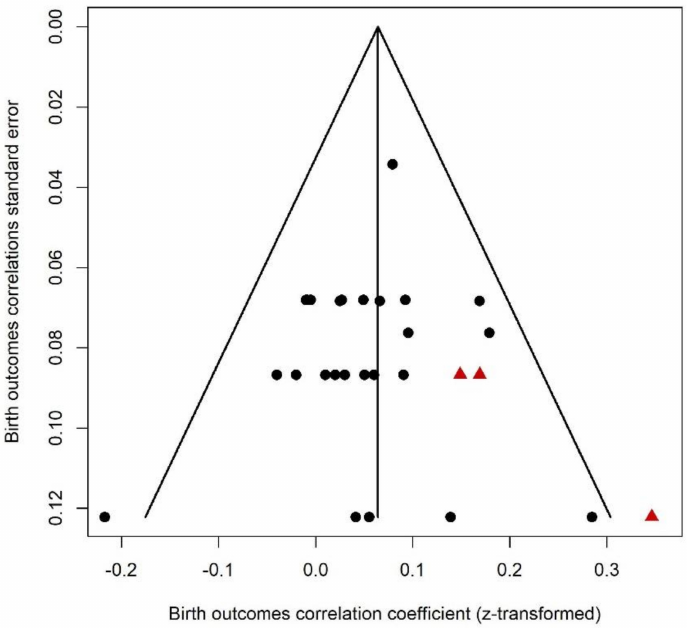
Figure 3. Birth Outcomes Funnel Plot. Three positive effect sizes were added and represented by red triangles.